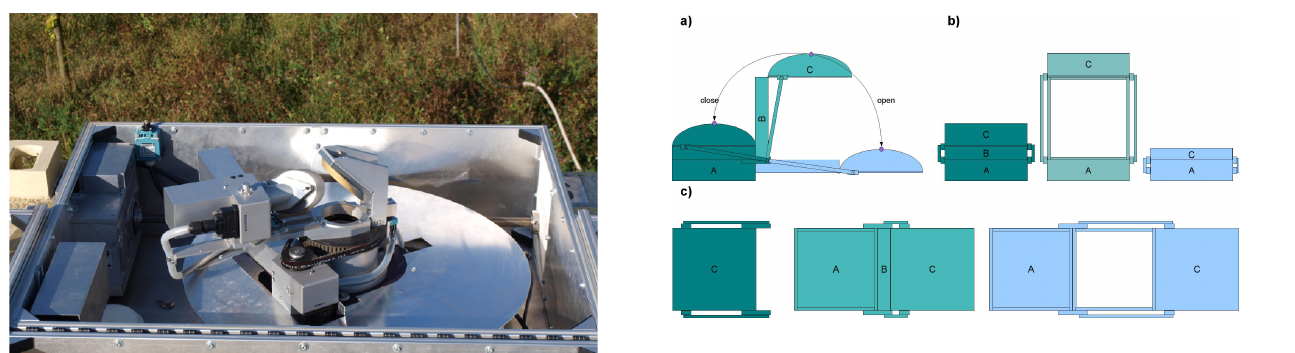
Fig. 4. Schematic overview of the BGC-FTIR Solar Tracker Dome in side (a) , front (b) and top view (c) . Equal colours represent equal states of the dome. The dome consists of a frame of aluminum x- profile beams that are covered with aluminum plates. Its z-shaped movement is realized by two arrays of hinges and a moving lever. The middle part (Part B) is an open frame. The upper part (Part C) of the lid always faces